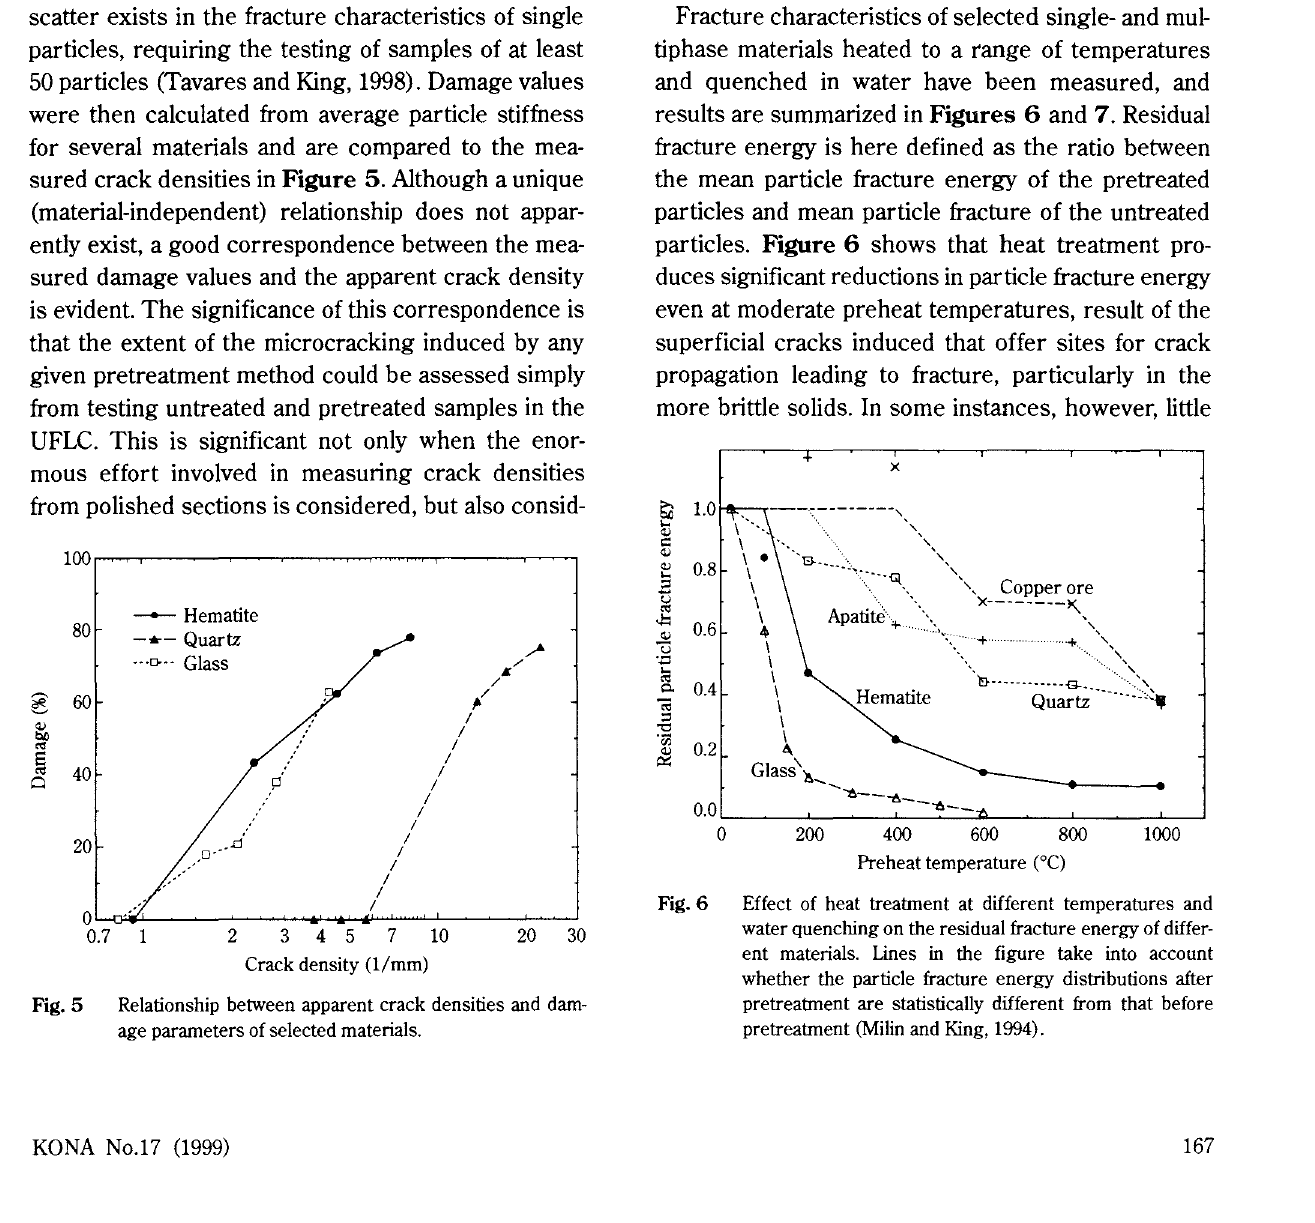
Force-deformation profiles for untreated and heated to 1000°C and water quenched quartz particles (4.0-4.75 mm).